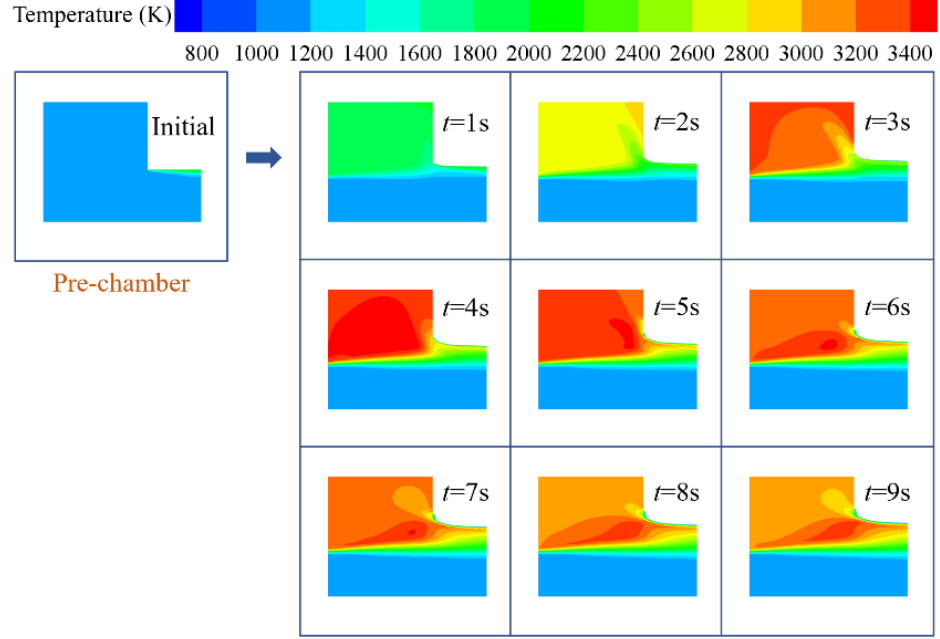
Figure 11. Temperature contour of the pre-chamber.